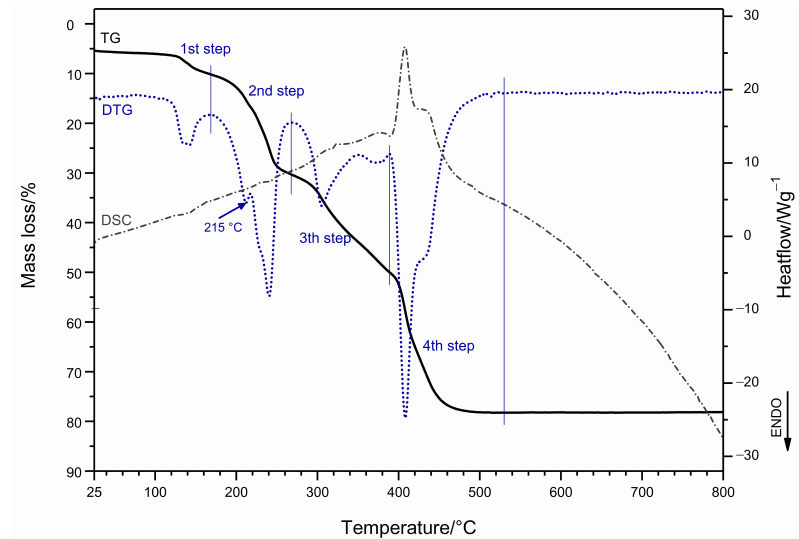
Figure 5. TG (black line), DSC (black dot line) and DTG (blue dot line) curves in air of compound 1 .